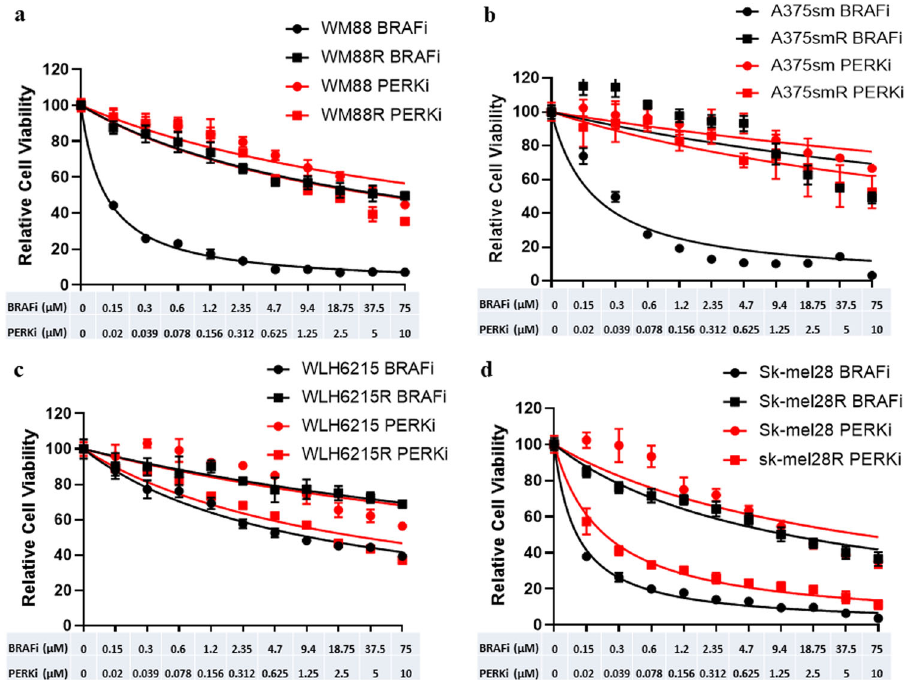
Fig. 2 A PERK inhibitor could inhibit the cell survival of BRAFi – resistant melanoma with impaired PTEN. WM88 ( a ) and A375sm ( b ) cells with wild-type PTEN or WLH6215 ( c ) and Sk-mel28 ( d ) cells with impaired PTEN and their PLX4032-resistant counterparts were treated with different concentrations of PLX4032 BRAF inhibitor (BRAFi) and GSK2606414 PERK inhibitor (PERKi). The cell viability curves of parental and resistant human melanoma cells were determined using CCK8 assays. Error bars denote s.d. for biological three